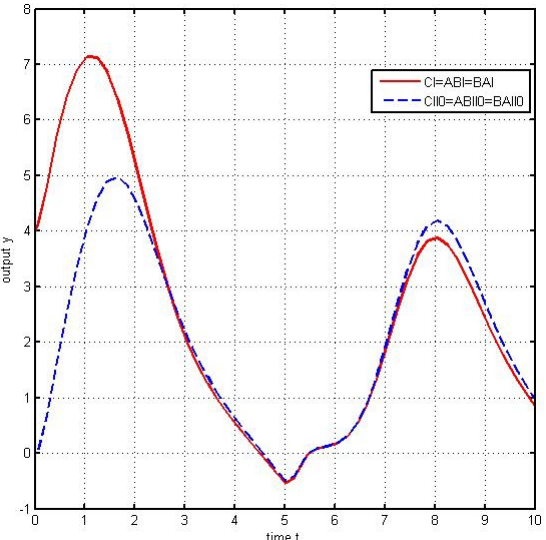
Fig. 3. Outputs of Example 2 for Cases I and